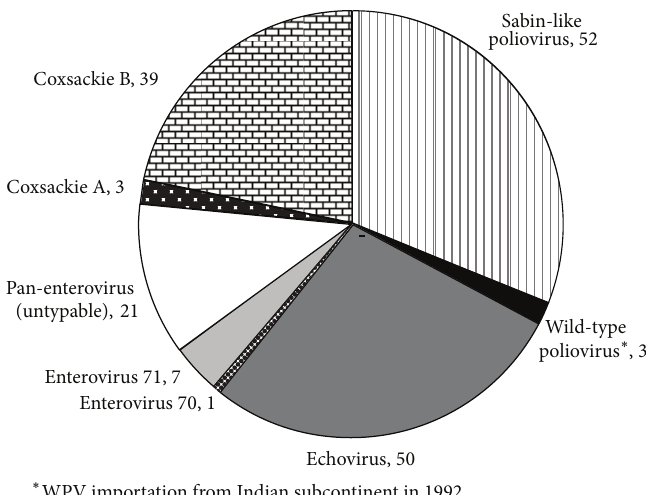
Figure 1: Polioviruses and non-polio enteroviruses isolated from AFP cases from 1992 till